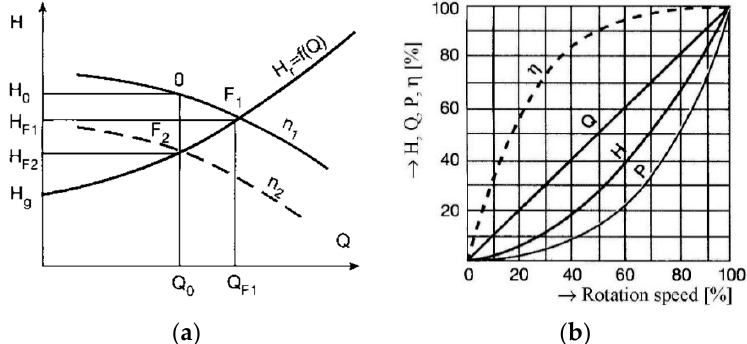
Figure 18. Quantitative regulation with variable-speed pumps (VSPs): ( a ) Discharge regulation by varying pump speed; ( b ) Centrifugal pump curves depending on rotation speed [123].